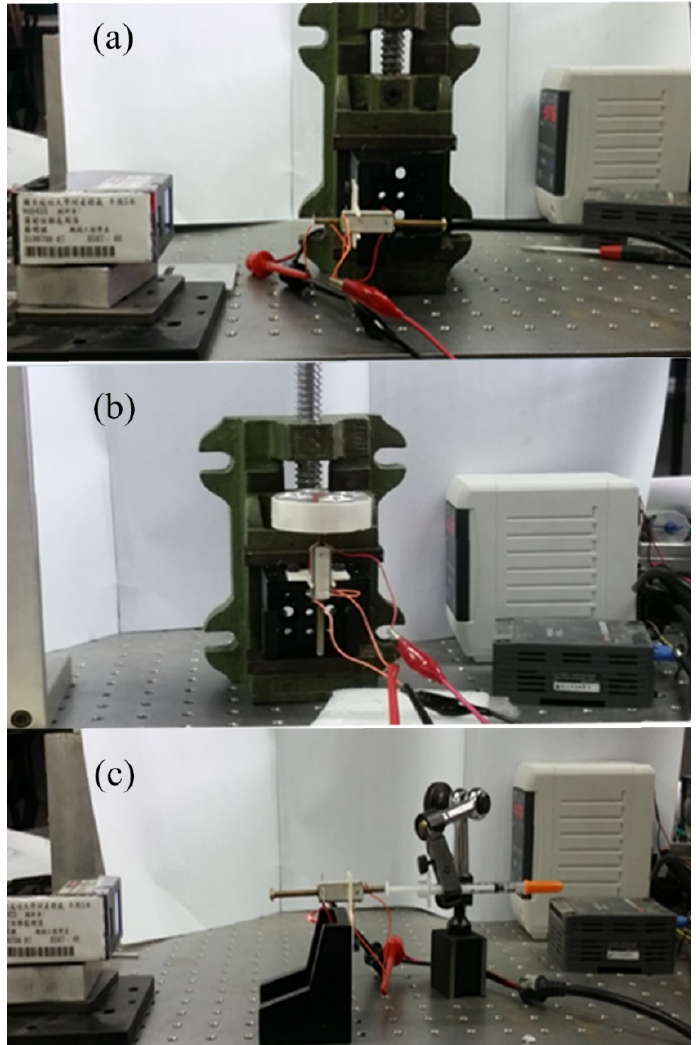
Figure 13. A picture of ( a ) the leftward or rightward motion for a squiggle motor, ( b ) the upward motion and ( c ) pulling a syringe using a squiggle